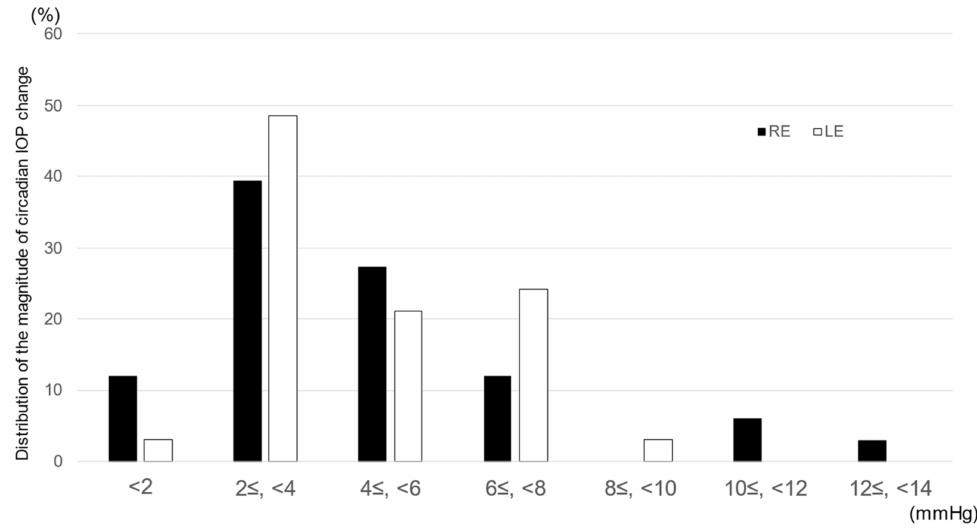
Figure 2. Distribution of mean diurnal intraocular pressure change during the measurement period. RE: right eye, LE: left eye.